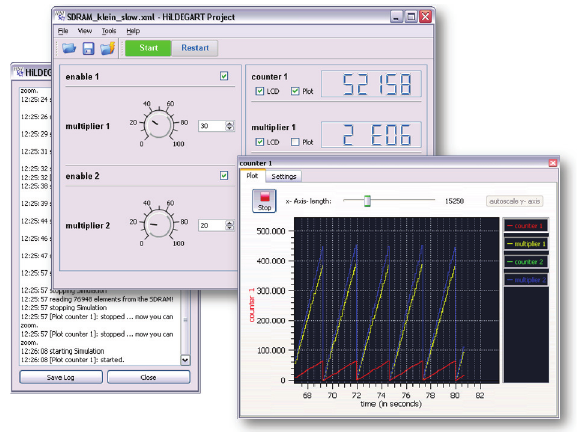
Figure 5: Main-, Log-, and Plot-Window of HiLDEGART. The GUI is generated from an XML file generated by a vMAGIC application.